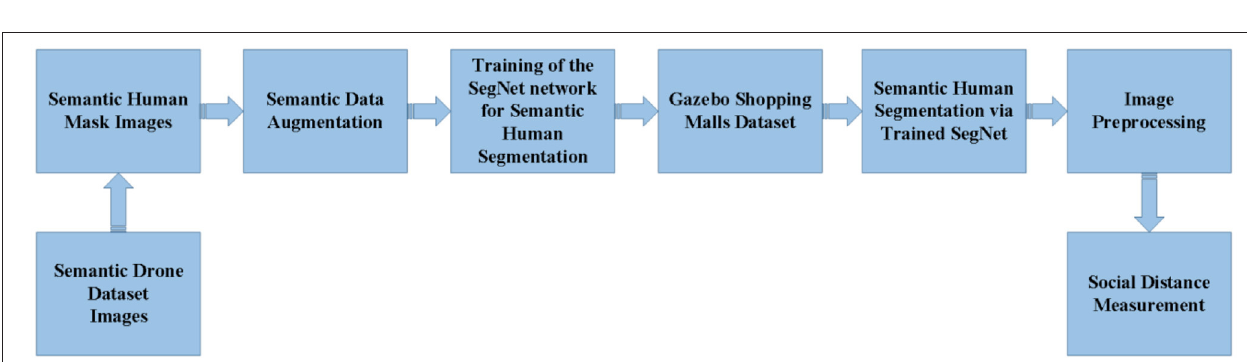
FIGURE 7 | Application steps of human semantic segmentation using UAV (First, the SegNet architecture is trained with the public dataset. Then the trained SegNet architecture is tested on our dataset. After the human detection, the social distance between people is determined by image processing).